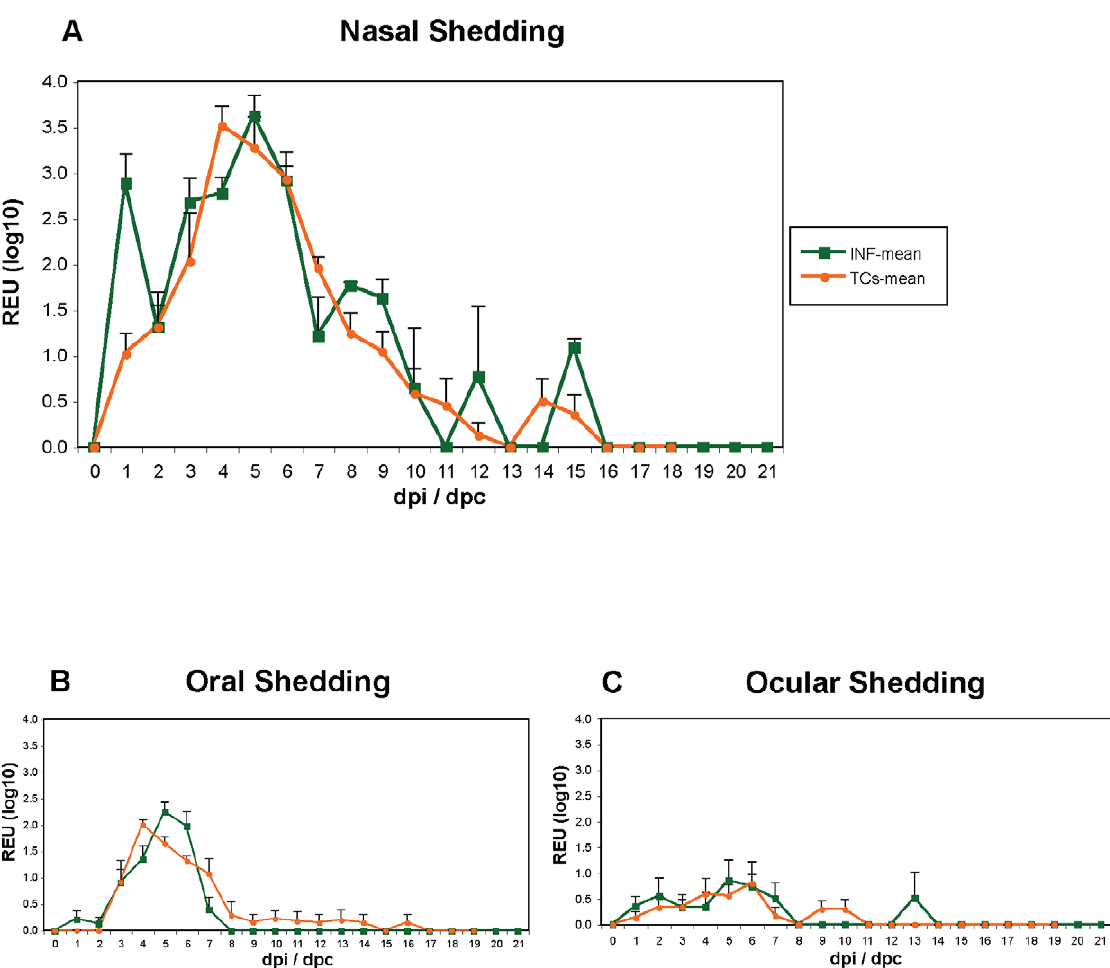
Figure 1. Semi-quantitative H1N1/09 virus shedding. Shedding from infected (INF) and transmission cycle (TC) pigs from the nasal (a), oral (b) and ocular (c) routes. Shedding expressed as (REU log 10 ; mean + SE). Relative equivalent units (REU) represent an equivalent viral infectivity titre related to RRT-PCR threshold cycle (Ct) values. dpi/dpc refers to days post infection/contact.